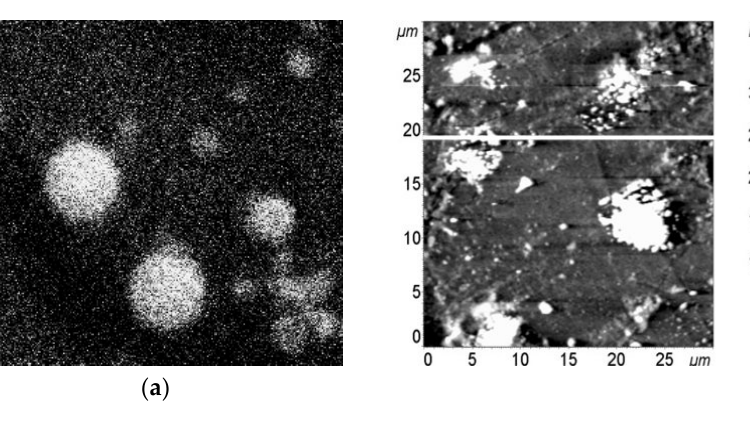
Figure 13. SEM and AFM images of the graphene surface of the same Group 1 chip as in Figure 9 with aggregates of influenza B antigen viruses. ( a ) SEM image of a 5 × 5 μ m 2 surface. ( b ) AFM images. On the ( left )—graphene surface. On the ( right )—profile of the graphene surface along the line in the figure on the ( left ). The peaks in the graph reveal the aggregates on the graphene surface with a height up to 250–350 nm.